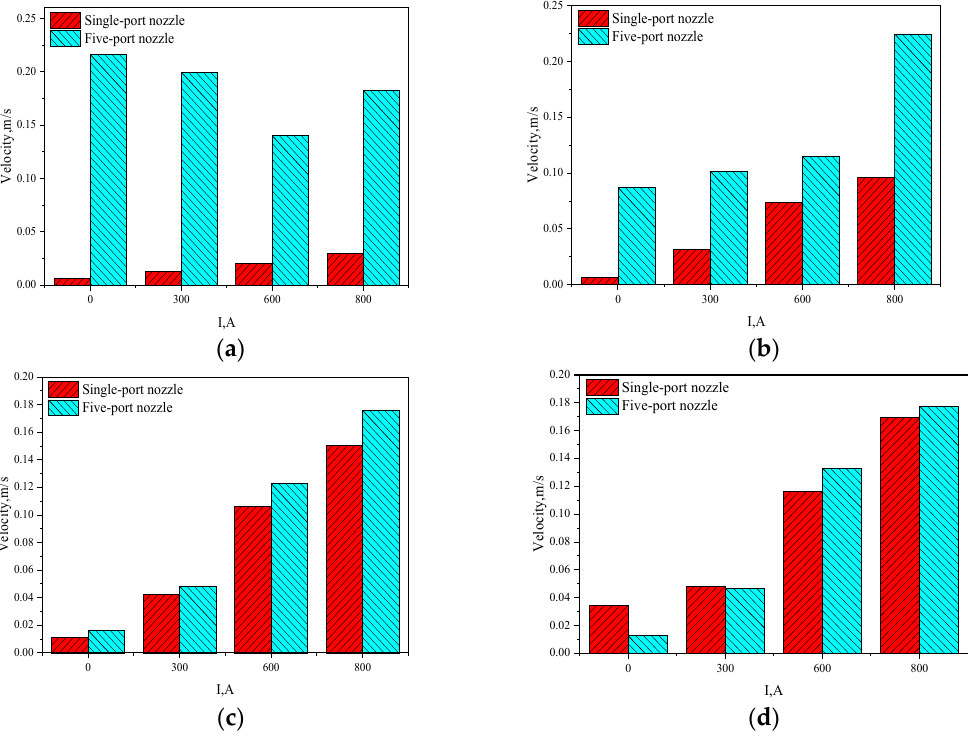
Figure 6. Maximum washing velocity at solidification front: ( a ) Z = 130 mm; ( b ) Z = 300 mm; ( c ) Z = 480 mm; ( d ) Z = 635 mm.